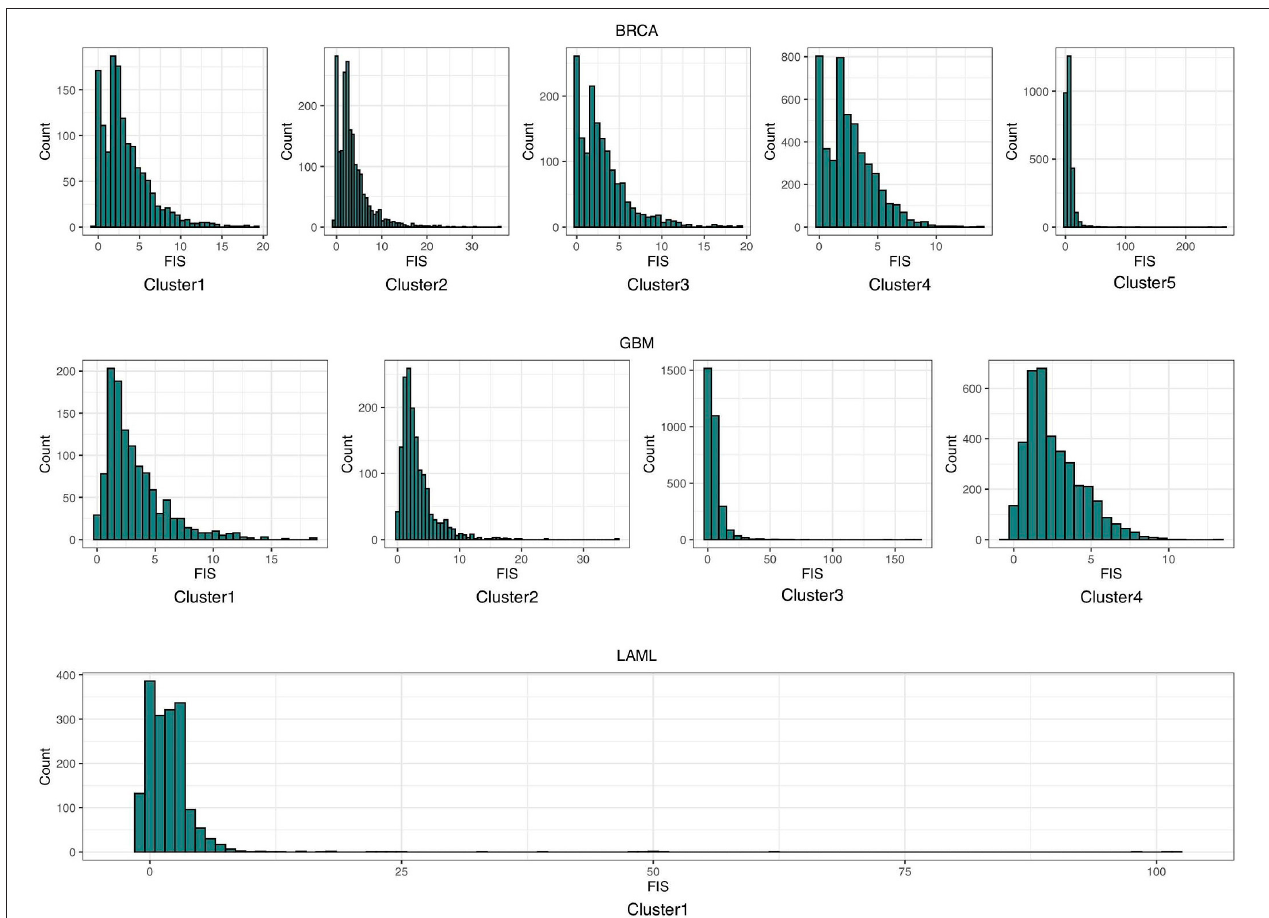
FIGURE 3 | The histograms of the estimated functional impact scores (FISs) in breast invasive carcinoma (BRCA), glioblastoma multiforme (GBM), and acute myeloid leukemia